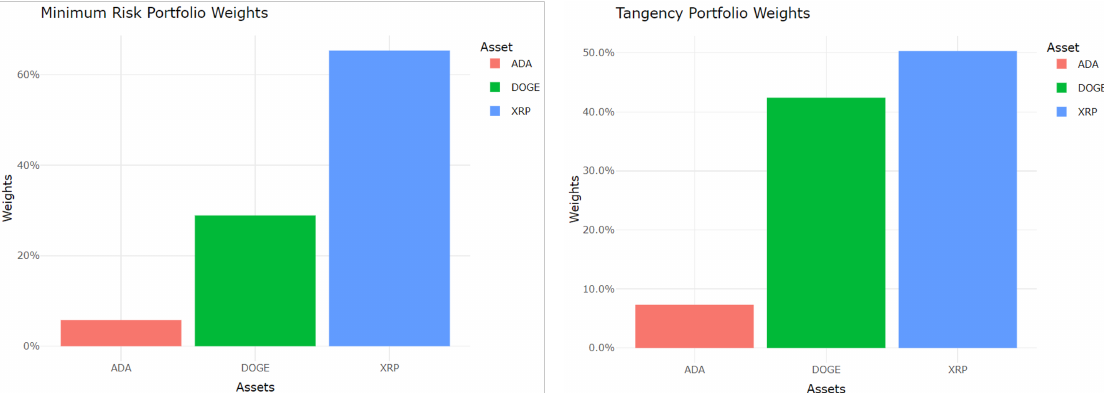
Figure 12. The asset weights assigned using MRP-VESV and MMRP-VESV for Cryptocurrency (Group 2)